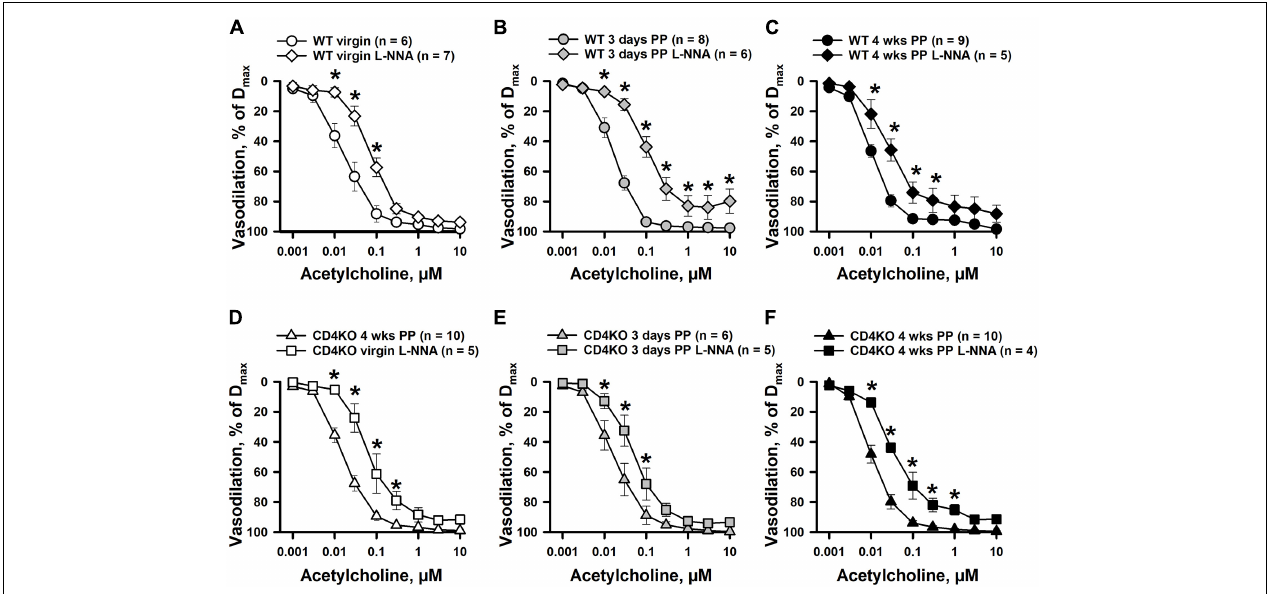
FIGURE 6 | The effects of NOS inhibition with L-NNA on acetylcholine (ACh)-induced vasodilation of internal carotid arteries (ICAs) from virgin and postpartum (PP) C57BL/6 wild-type (A–C) and CD4KO (D–F) mice. In all tested groups of mice, a blockade of NO production resulted in a significant shift in ACh concentration-response curves. In the presence of L-NNA, ACh still induced near maximal dilatation of ICAs (* P < 0.05, two way ANOVA).